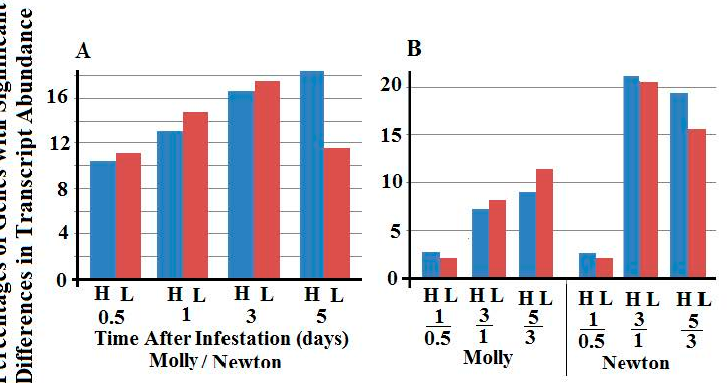
Figure 1. Percentages of total genes with higher (blue bars, H) and lower (red bars, L) transcript abundance. ( A ) Percentages of genes with higher and lower transcript abundance between larvae feeding in resistant (Molly) and susceptible (Newton) plants at 0.5, 1, 3, and 5 days; ( B ) Percentages of genes with higher and lower transcript abundance between two successive stages of Hessian fly larvae feeding in either resistant (Molly) or susceptible (Newton) plants.